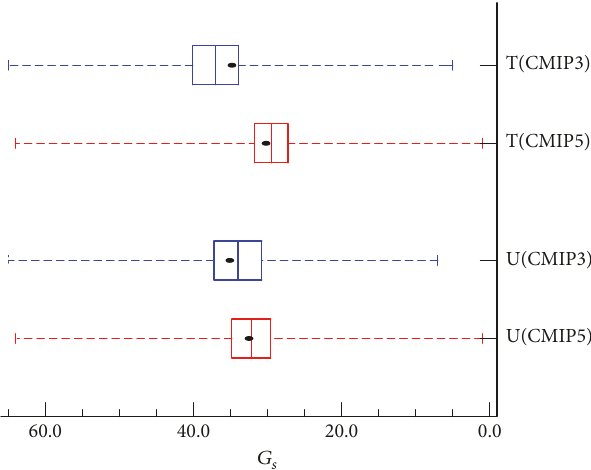
Figure 3: Box plots of the 𝐺 𝑠 rankings of the zonal-mean zonal winds (left) and zonal-mean temperatures (right) for the polar cap region (60 ∘ –90 ∘ N, 50–10hPa) from the CMIP5 (red) and CMIP3 (blue) models. The middle values are the multimodel means, and the dots are the median values of the models; the upper and lower values are shown for the uncertainty range of the mean, and the uppermost and lowermost bars are the maximum and minimum values.